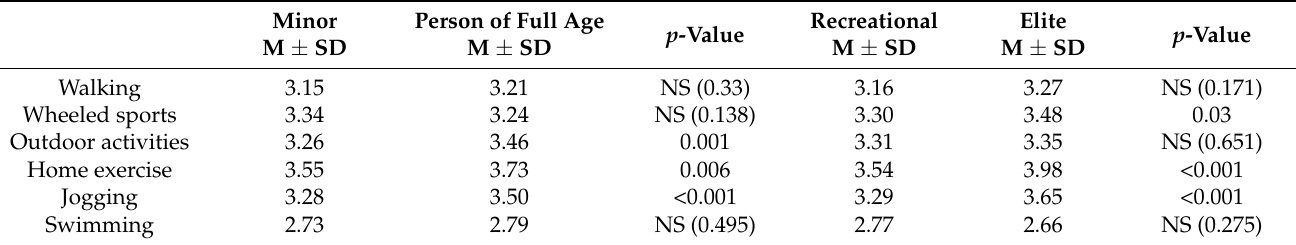
Table 5. Comparisons between physical activity practices before and during the global pandemic according to age and competitive level.